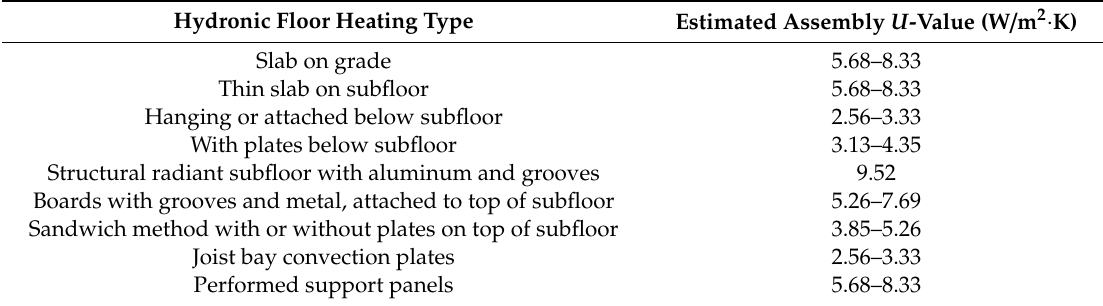
Table 1. Floor heating assembly configurations and the corresponding R